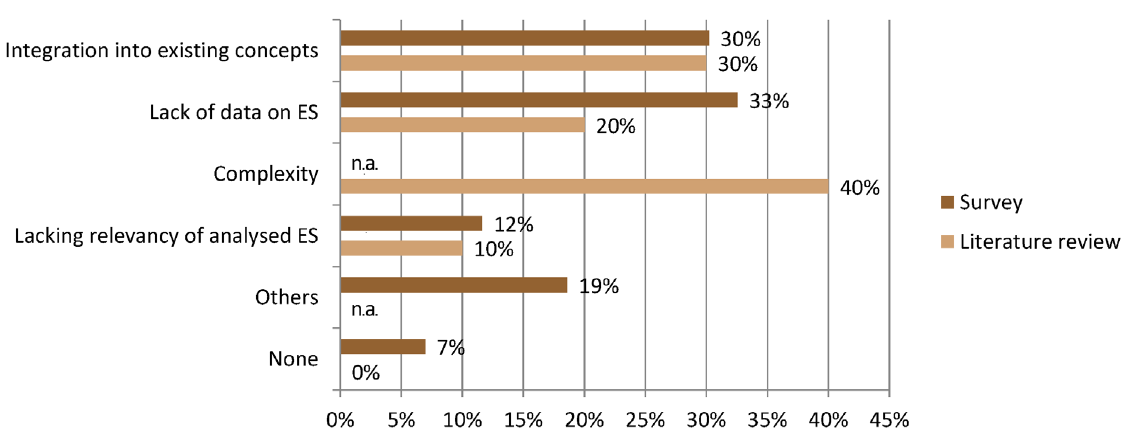
Figure 6: Challenges related to using the ES concept in participatory processes (survey: 67 mentions; literature review: 10 mentions)